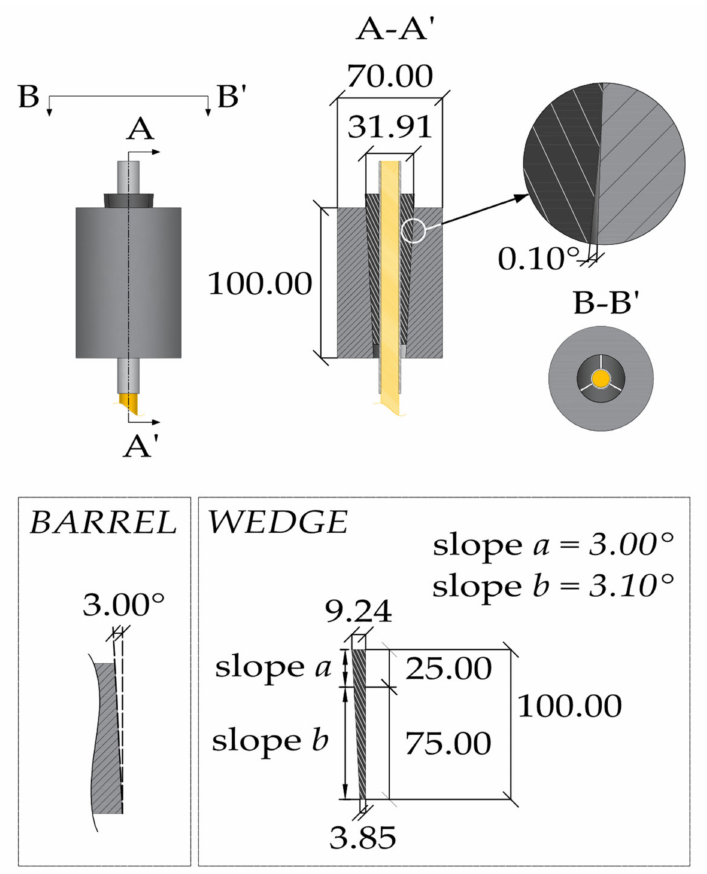
Figure 14. Proposed double-angle wedge anchorage: geometry (dimensions in